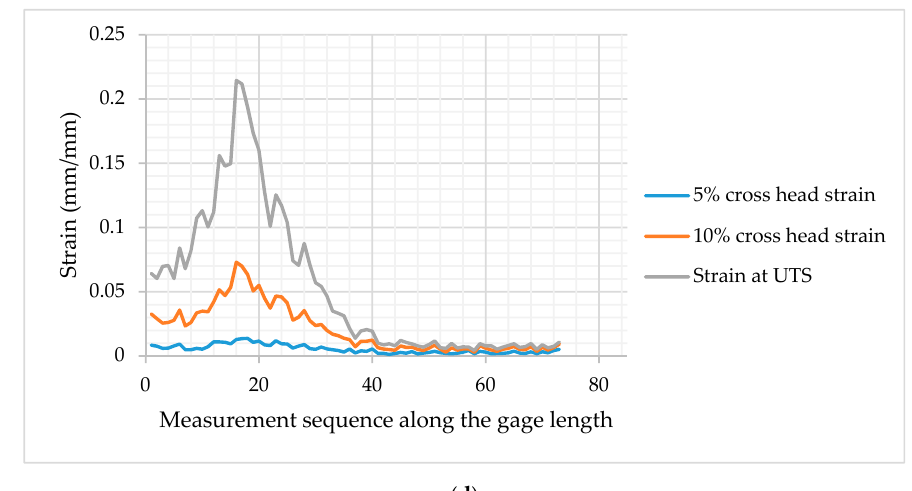
Figure 18. Strain values calculated along the center-line of the gage lengths of miniature tensile specimens cut from deposits of ( a ) Set 1 duty cycle for 100/0 on 30/70, ( b ) Set 1 duty cycle for 30/70 on 100/0, ( c ) Set 3 duty cycle for 100/0 on 30/70, and ( d ) Set 3 duty cycle for 30/70 on 100/0. While the difference in strengths pointed to chemistry differences, the influence of the duty cycle was not as anticipated. For a given combination of pre-deposit and deposit, the change in transition length did not correlate with the strength variation. In both the cases, with an increasing duty cycle, the strength was seen to drop.